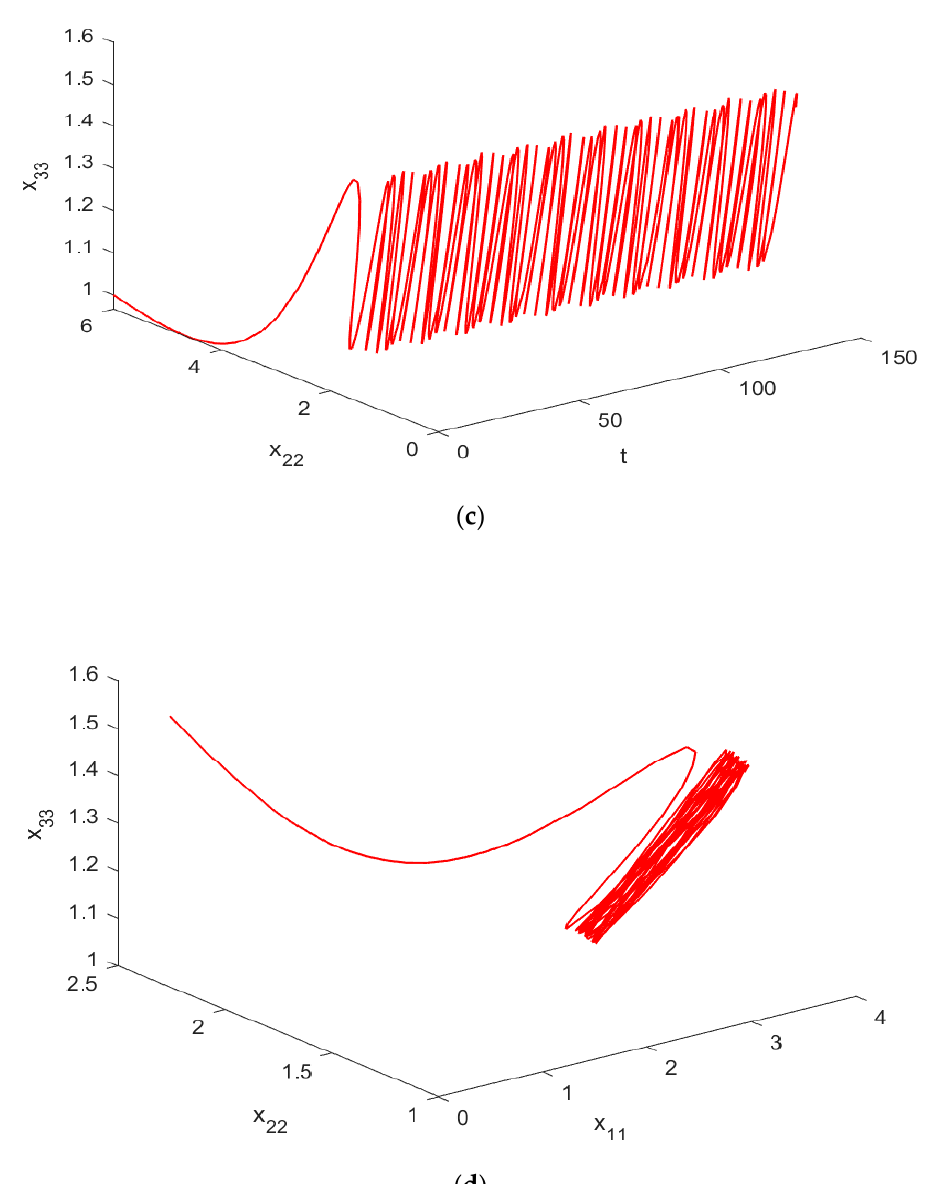
x x − , 3D graphs and initial values are ( a ) (2.0,1.5), ( b ) Figure 9. The state trajectory of x 22 − x 33 , 3D graphs and initial values are ( a ) ( 2.0,1.5 ) , ( b ) ( 0.5,1.0 ) , Figure 9. The state trajectory of 22 33 ( c ) ( 0.0,6.0,1.0 ) , and ( d ) ( 0.5,2.5,1.5 ) , (0.5,1.0), ( c ) (0.0, 6.0,1.0), and ( d ) (0.5, 2.5,1.5), respectively.